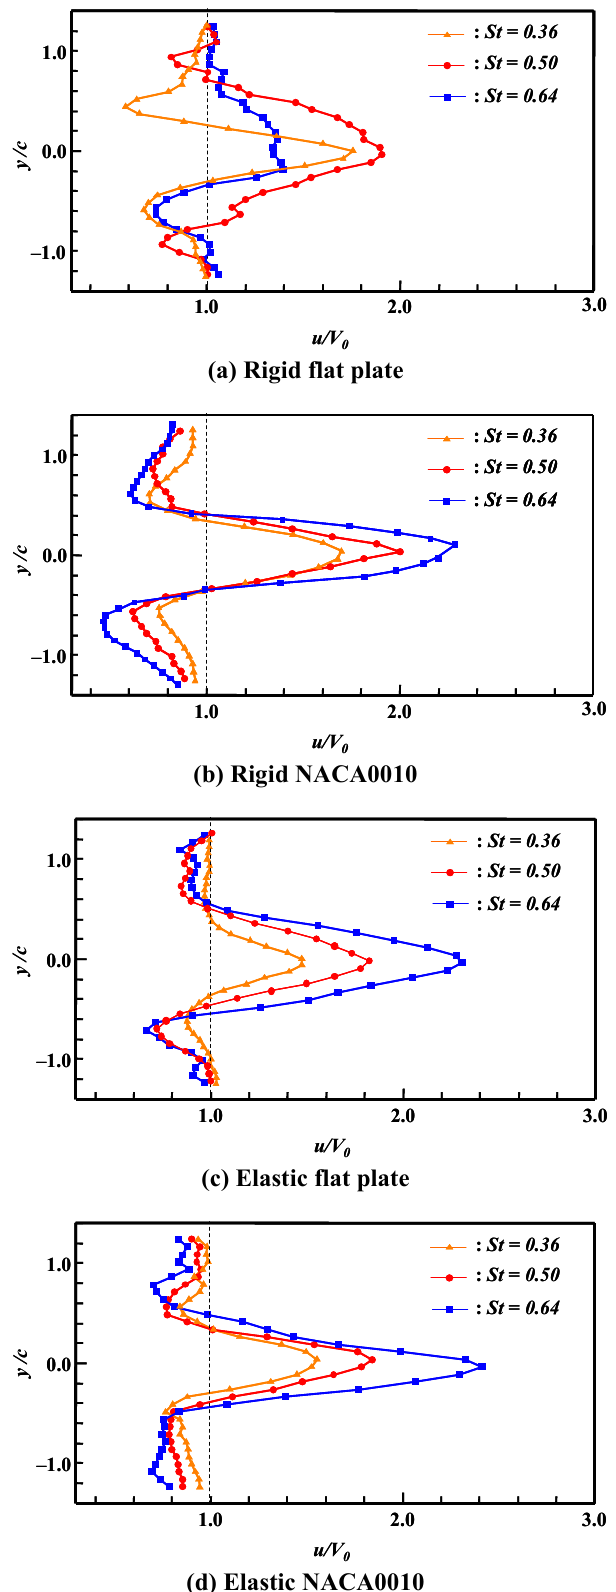
Fig. 7 Mean velocity profile one-chord length behind the heaving airfoils for one cycle